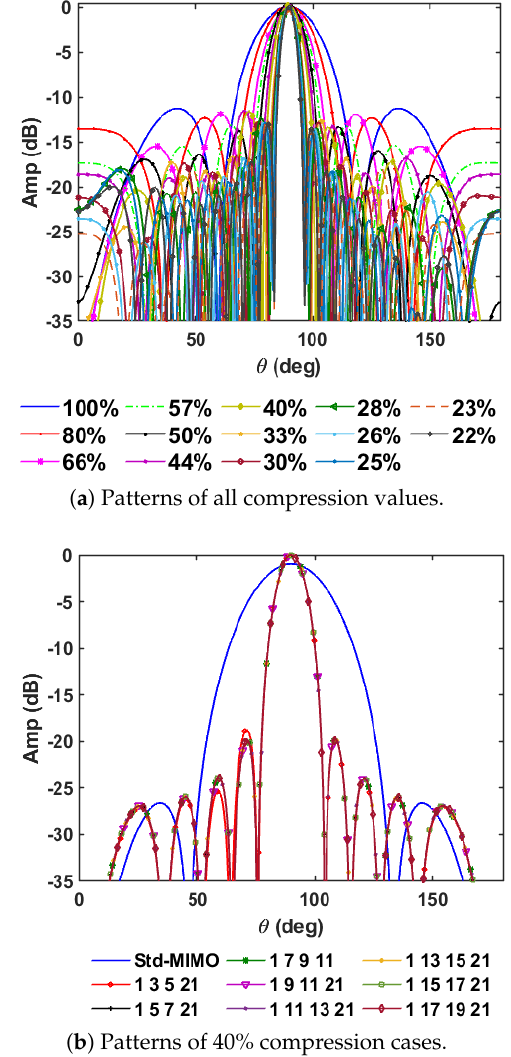
Figure 2. Simulated normalized power plots of a target in front of the MIMO radar for the cases reported in Table